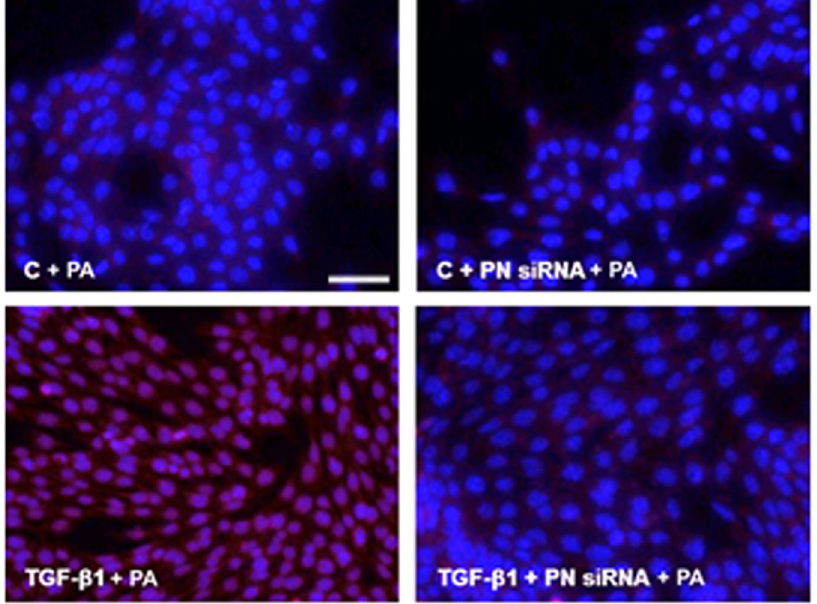
Figure 3. Specific attachment of the periostin-binding DNA aptamer (PA) to periostin expressed in inner medullary collecting duct (IMCD) cells. IMCD cells were treated with or without transforming growth factor- β 1 (TGF- β 1) (10 ng/ml), periostin siRNA (100 nM), or Cy3-tagged PA (100 pmol/ml). The intensity of Cy3 was significantly increased in TGF- β 1-stimulated IMCD cells treated with the Cy3-tagged PA (scale bar, 50 μ m). This effect was abrogated significantly by periostin siRNA transfection ( × 400). C, control; PN siRNA, periostin siRNA; PA, periostin-binding DNA